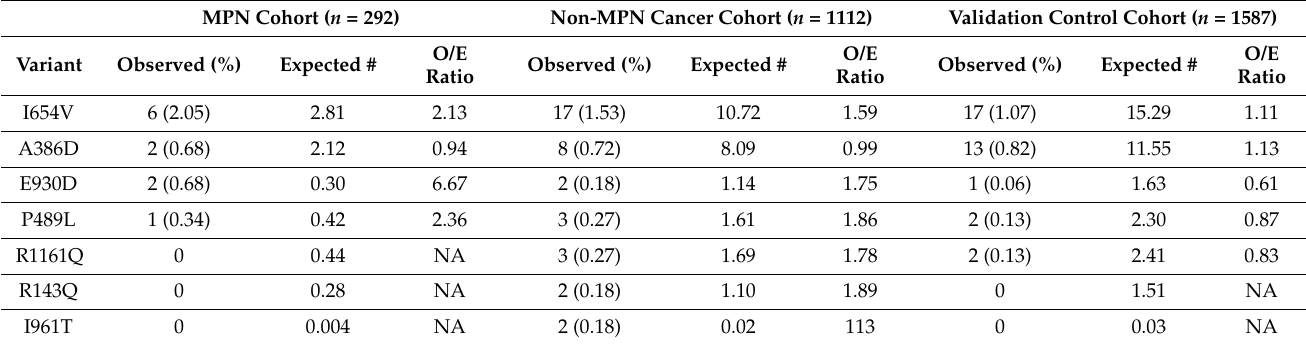
Table 2. ERBB2 variants identified in multiple cancer